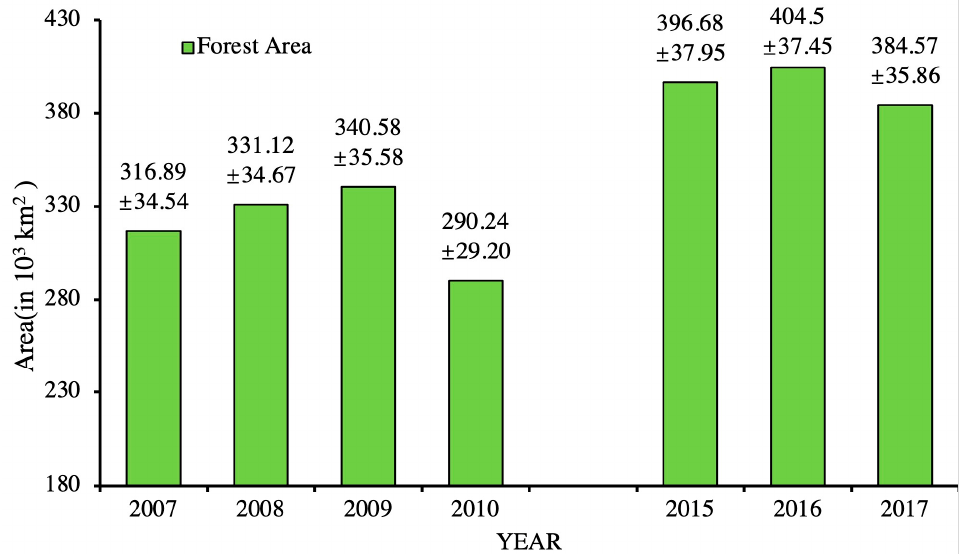
Figure 8. Forest area variation in northern China from 2007 to 2017. The forest area from 2007 to 2017 was adjusted based confusion matrix by 95% confidence intervals.